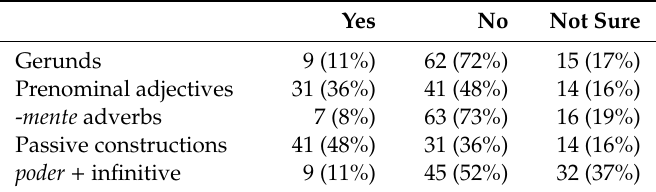
Table 2. Students’ responses to whether the features constitute anglicisms ( N = 430).